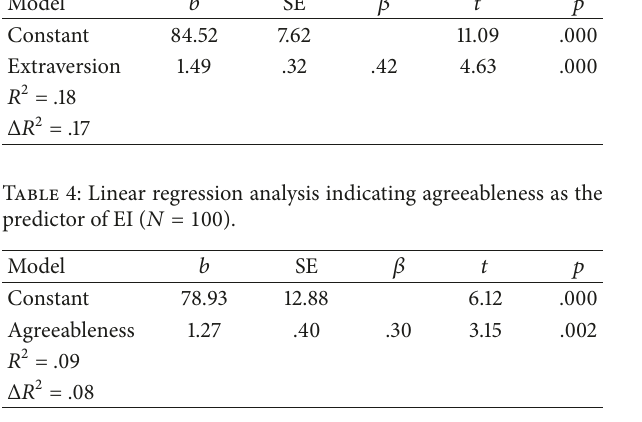
Table 5: Linear regression analysis indicating conscientiousness as the predictor of EI ( 𝑁 = 100 ).